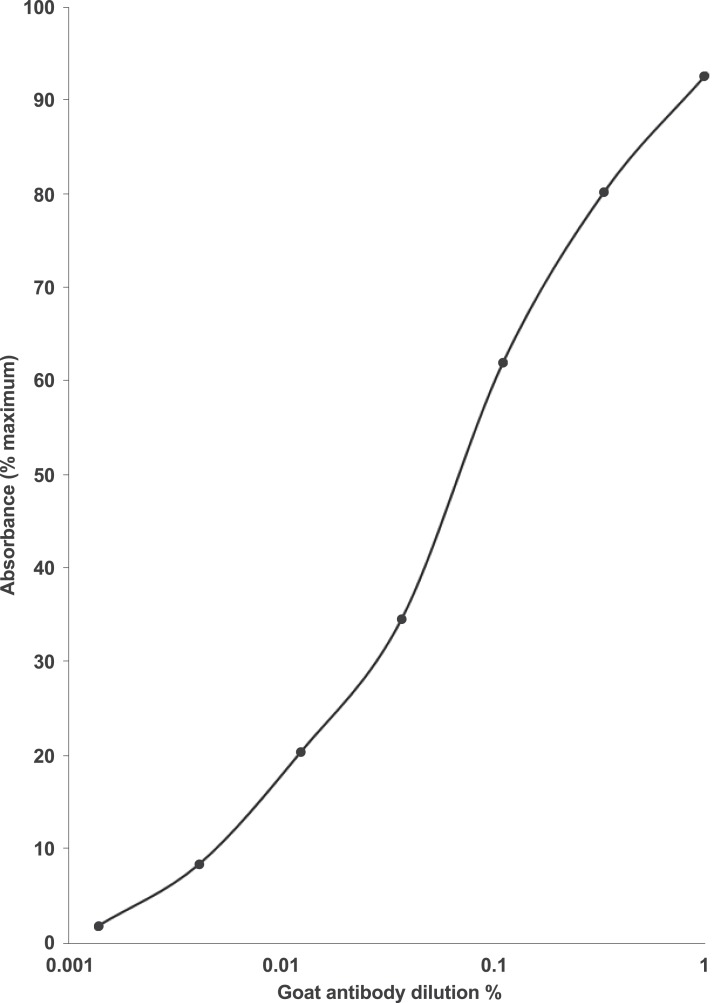
Dilution curve for the anti-EPL001 goat polyclonal antiserum G530.ELISA 96-well microtitre plates were coated with 10 ng/well of EPL001 and left overnight in the presence of the primary antibody at +4 °C, before incubation with a donkey anti-goat secondary antibody conjugated with horseradish peroxidase. Absorbance was measured at 450 nm. Relative absorbance (%) was expressed against the whole number absorbance value immediately above the maximum reading obtained with the antibody. The averages of duplicate values are presented.